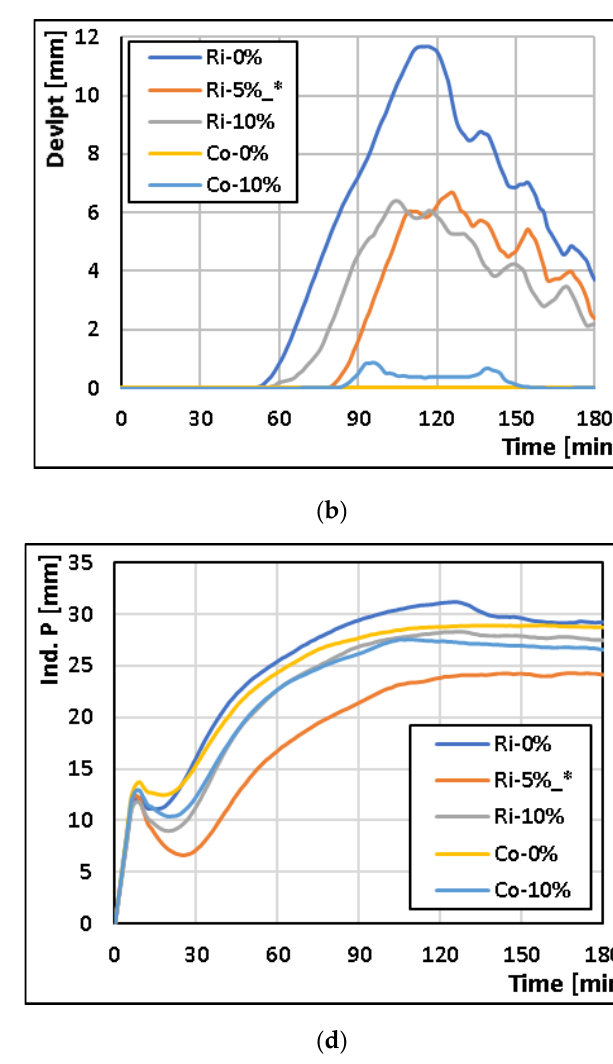
Figure 7. Comparison of the output signal U out from the experimental TDS with the output signals from the professional Rheofermentometer RF-4 (Chopin, France): ( a ) Output signal U out [V] from the TDS; ( b ) Dough development curve [mm]; ( c ) Gas release curve—Total volume; ( d ) Gas release curve—Retention volume.